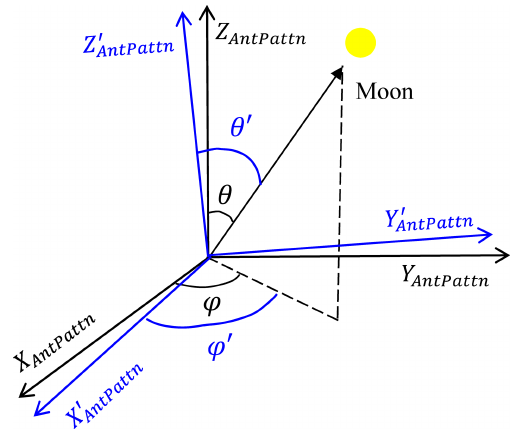
Figure 3. Schematic illustration of the moon vector in the antenna ,Y (cid:48) pattern frame. X (cid:48) , and Z (cid:48) are the real axes AntPattn AntPattn AntPattn of the frame and X AntPattn ,Y AntPattn , and Z AntPattn are the nominal axes with beam boresight pointing error. θ (cid:48) and ϕ (cid:48) and θ and ϕ are the zenith and azimuthal angles of the moon vector determined in the real and nominal frames,